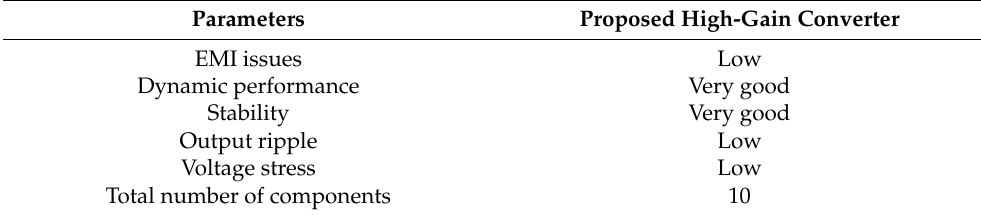
Table 3. Detailed behavior of the proposed high-gain converter.